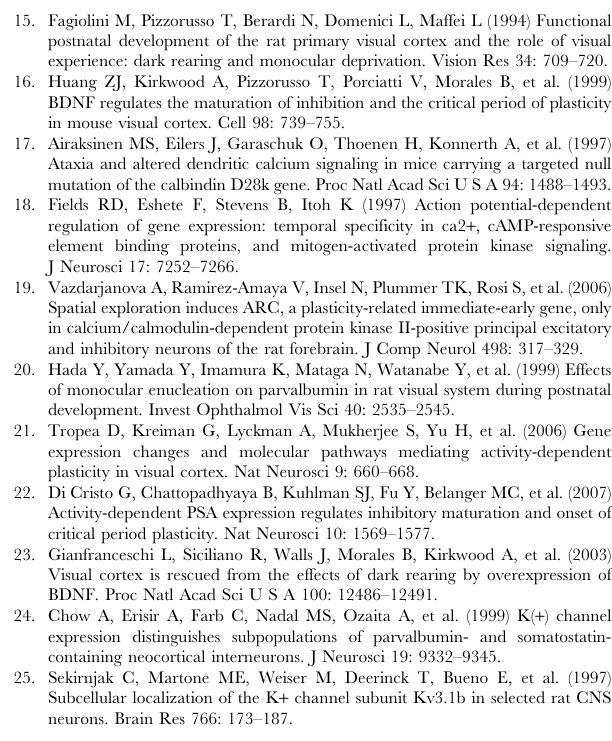
Figure S2 MD reduces the number of CB-c-Fos double stained cells after visual stimulation of the deprived eye. Graph showing after long-term MD (t test, P , 0.05, N=